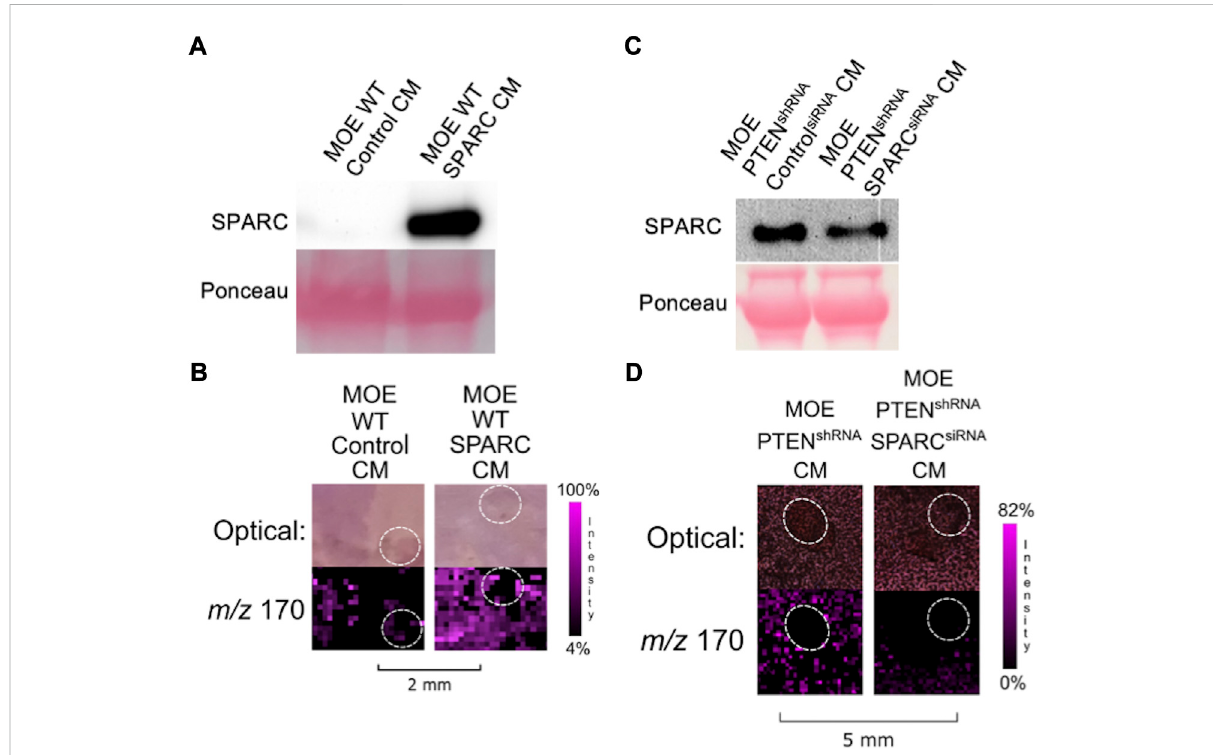
FIGURE 4 (A) Transfection of SPARC in MOE WT results in overexpression of SPARC protein compared to transfection with a control plasmid. (B) ConditionedmediafromMOEWTSPARCco-culturedwithovarianexplantresultsinincreasedNEsignalfromovary. (C) TransfectionofSPARC siRNA in MOEPTEN shRNA resultsinknockdownofSPARCexpressionandlesssecretionofSPARCproteinintoconditionedmedia. (D) Conditionedmediafrom MOE PTEN shRNA SPARC siRNA co-cultured with ovarian explant results in decreased NE signal from ovary. Ovaries are circled with a white dotted line. IMS Method B was used for this fi gure. CM stands for conditioned